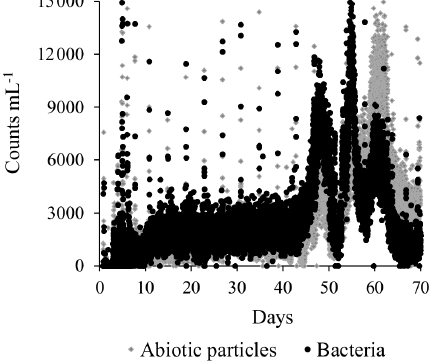
Figure 8. Time series of bacteria and abiotic particles in finished